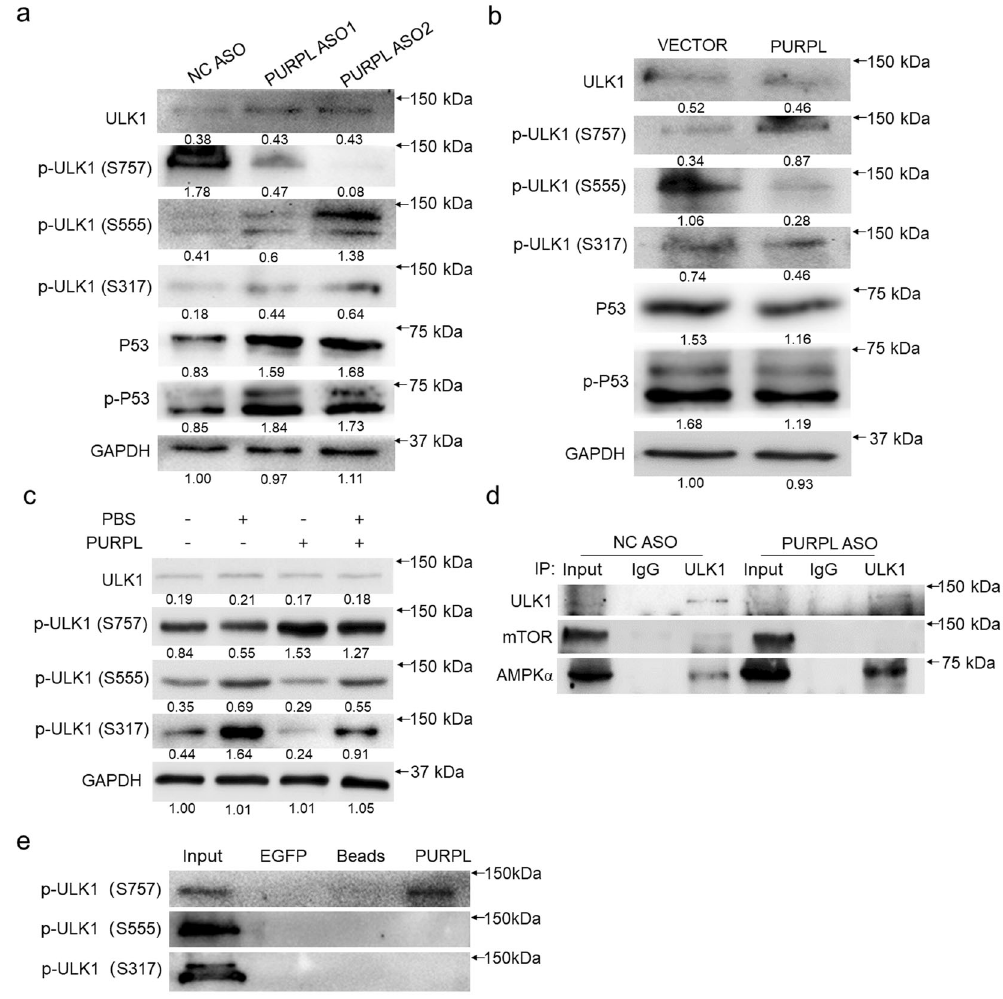
Fig. 6 PURPL interacts with mTOR and ULK1 to promote mTOR-mediated anti-autophagic phosphorylation of ULK1. a , b The phosphorylation status of ULK1 was detected using phosphorylation site-speci fi c antibodies against Ser757, Ser555, and S317 in response to PURPL knockdown or overexpression, while P53 and p-P53 were also detected by western blot. ULK1 and GAPDH were also detected as controls respectively. c ULK1 phosphorylations were detected using the above site-speci fi c antibodies to evaluate the role of PURPL